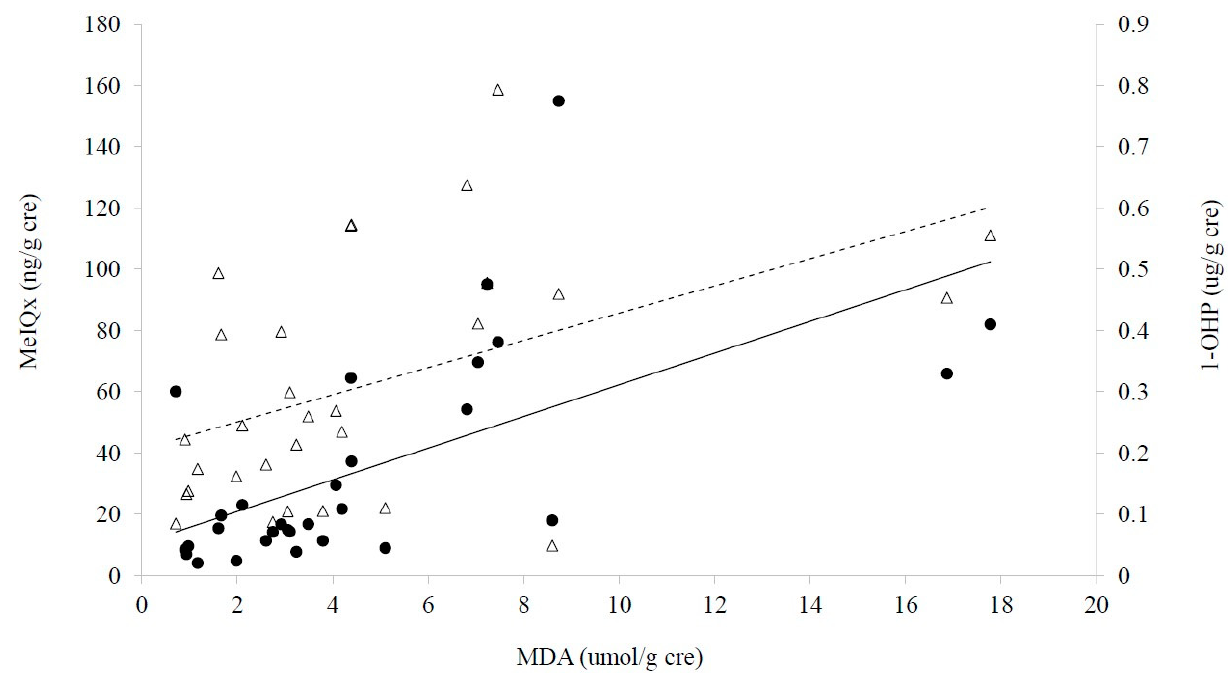
Figure 2. Associations among urinary MeIQx MDA, and 1 OHP levels Regression between urinary MDA and.MeIQx (0 67 P 0 01 dark circle and solid line) Regression between urinary MDA and 1 OHP ( 0 48P 0 01 triangle and dashed line) Regression between urinary MeIQx and 1 OHP ρ = 0 61 P 0 01. Table 4. Exposure biomarkers-associated fatty